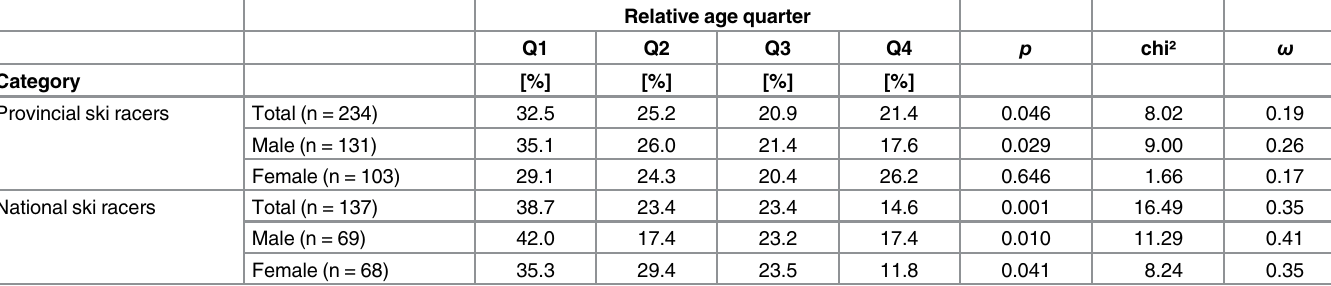
Table 2. Relative age quarter distributions of provincial and national ski racers according to gender.